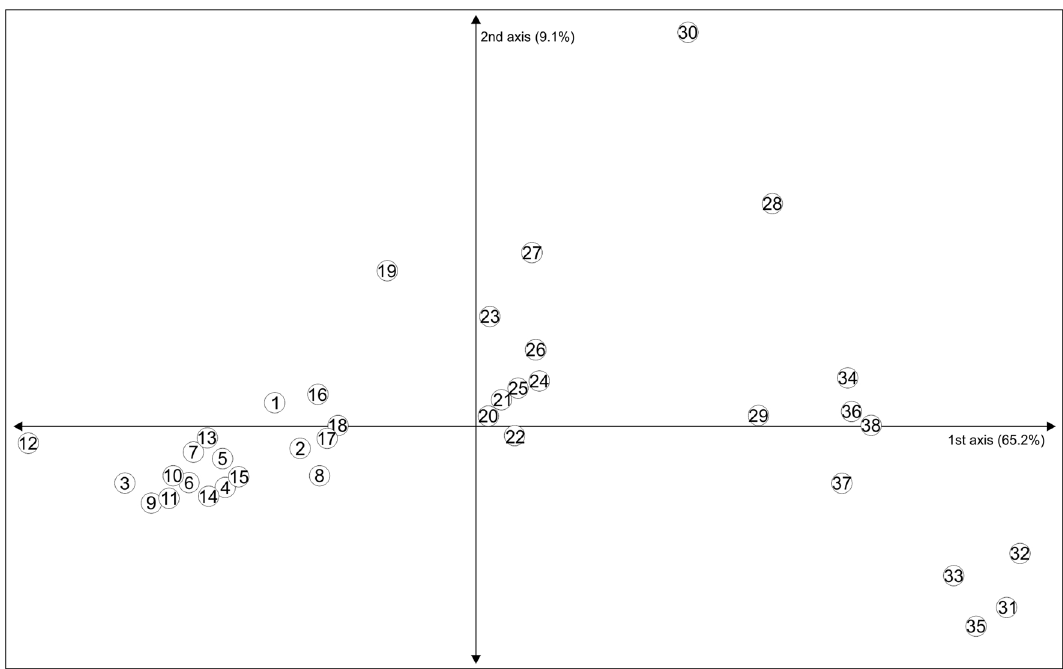
Figure 6. Genetic differentiation (Gst) of the studied populations visualised as a Principal Coordinate Plot showing the first two axes that cumulatively cover 74.3% of total variance. Populations are identified by their number as given in Table